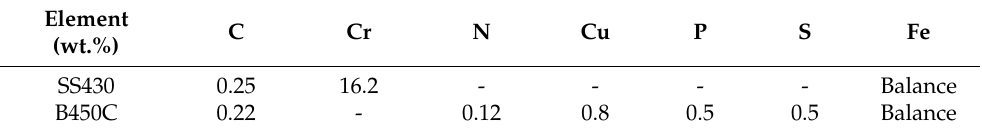
Table 1. Compositions (wt.%) of SS430 ferritic steel and B450C carbon steel, according to manufacturers. Element (wt.%)